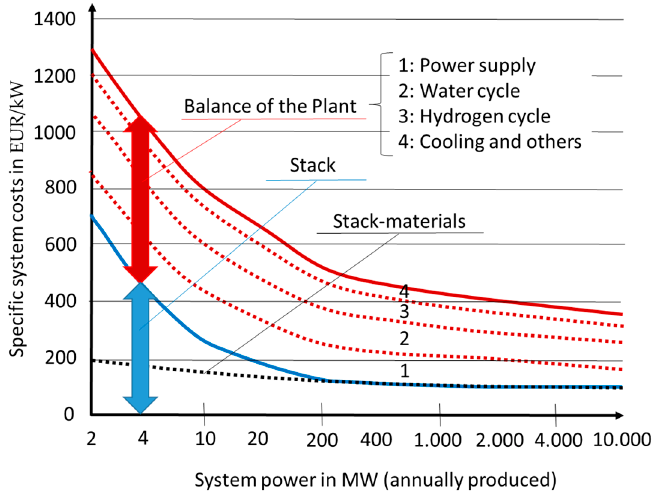
Figure 8. Specific manufacturing costs over system-power of PEM electrolysis systems in accordance with the study of the NREL in 2019 [50].